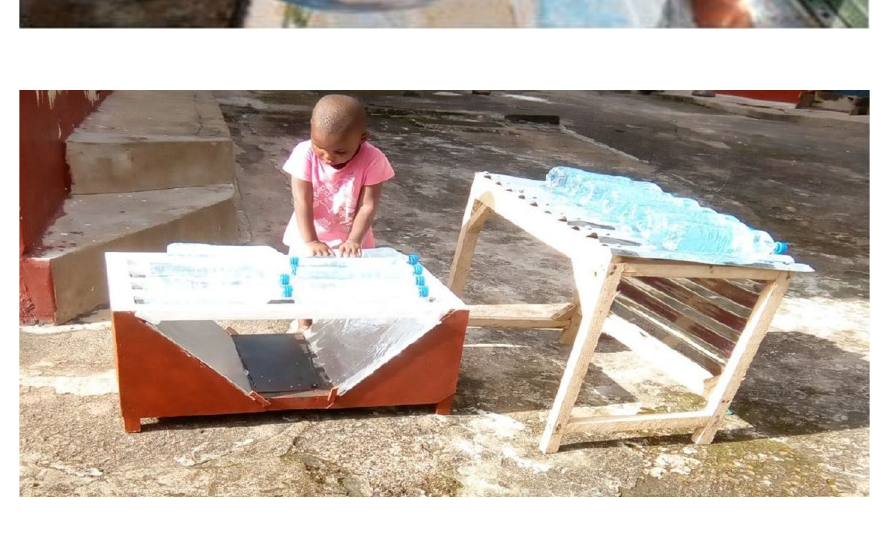
Fig. 5 Photograph of the Con- structed Improved